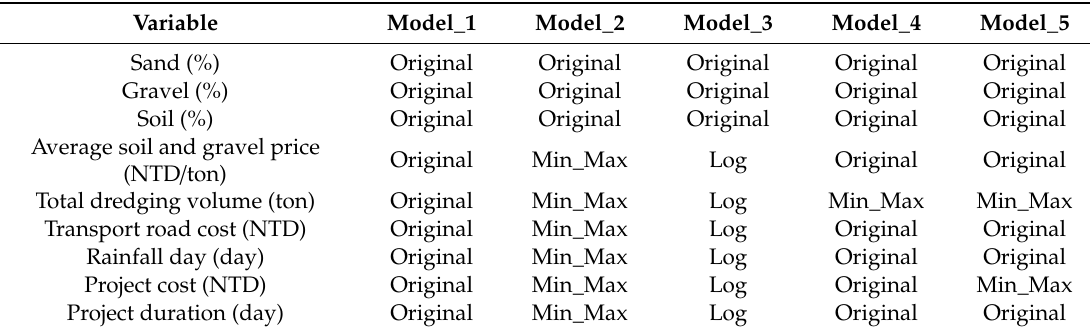
Table 2. Model descriptions and variable